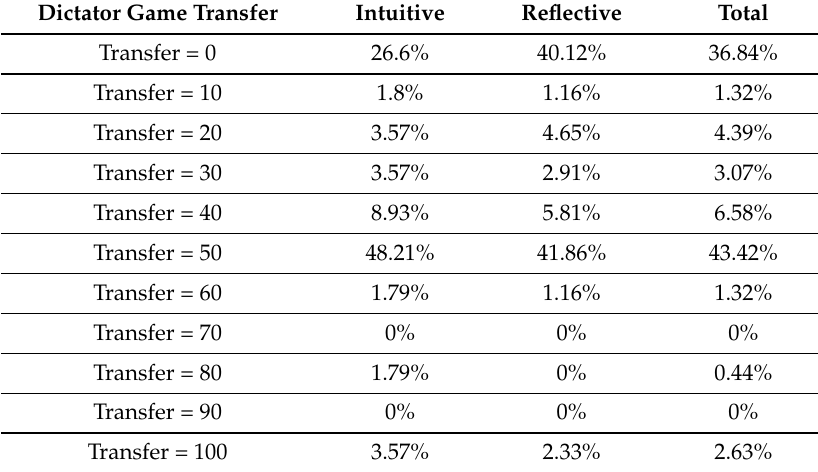
Table A1. Frequency of Dictator Game Transfer by Intuitive (Reflective)